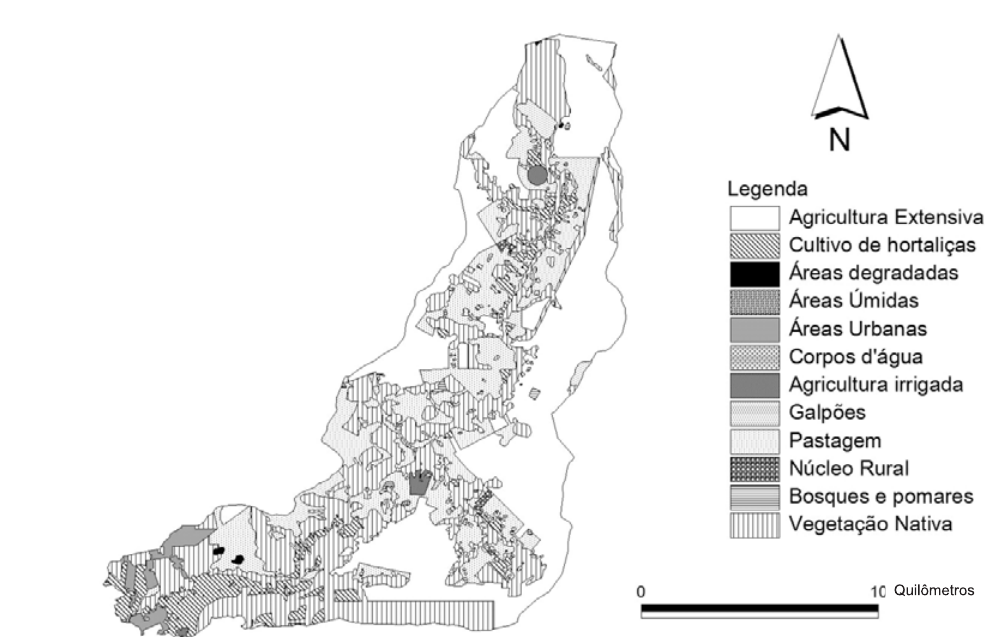
(2001).Figura 2. Tipos de uso do solo da bacia do ribeirão Pipiripau. Fonte: CAESB